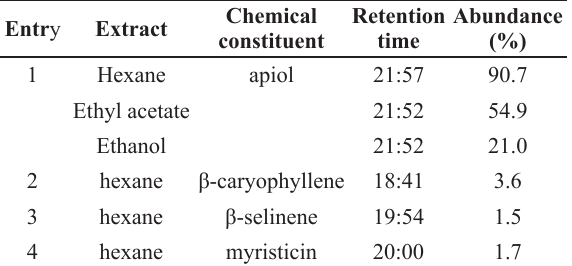
Chemical constituents identified in hexane, ethyl acetate, and ethanol extracts of Piper aduncum